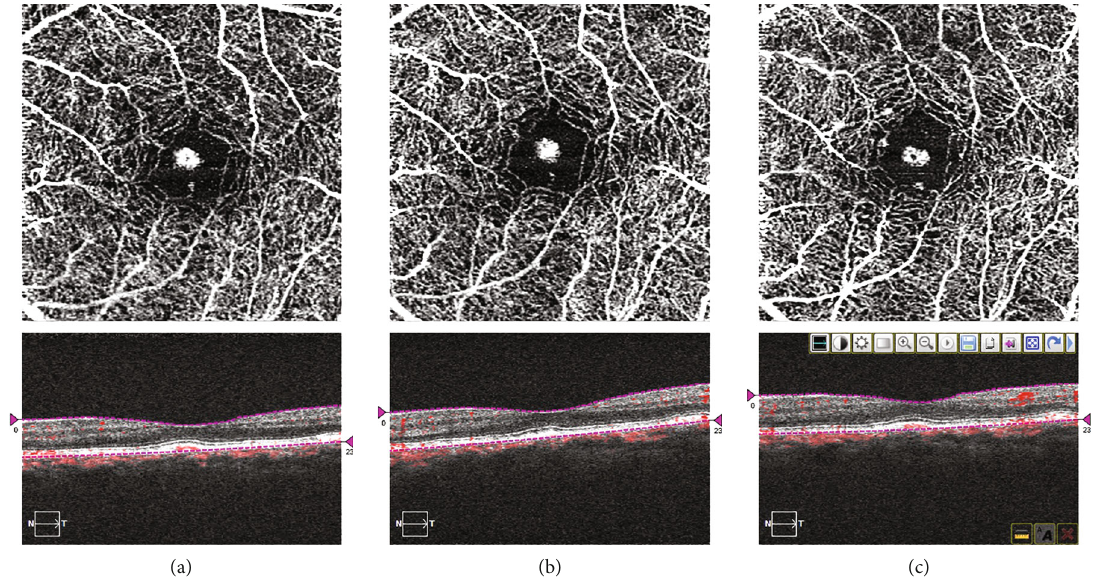
Figure 4: Optical coherence tomography angiography at baseline (a), 1 month later (b), and 13 months later (c) in the left